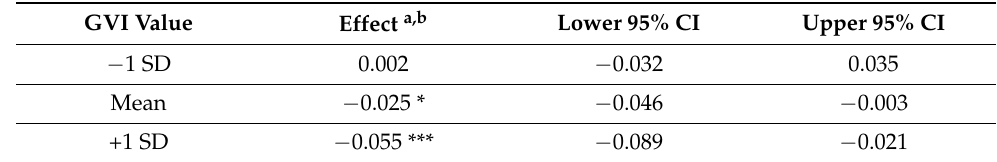
Table 3. Conditional effects of peer network health on substance use at the mean and +/ − 1 standard deviation of